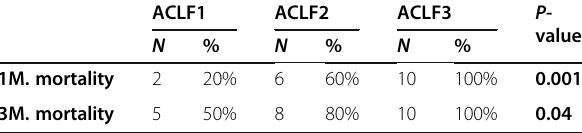
Table 9 Mortality between 3 ACLF groups in ICU ACLF1 ACLF2 ACLF3